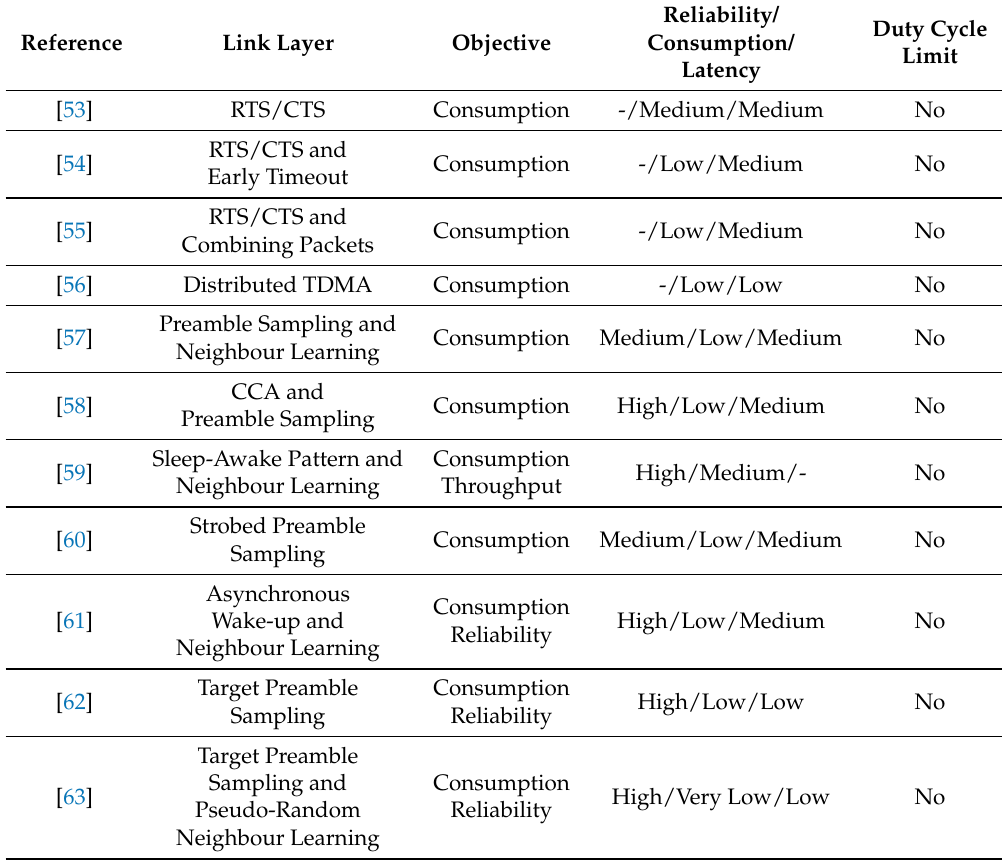
Table 2. Summary of the structure, main objectives and evaluation of the WSN